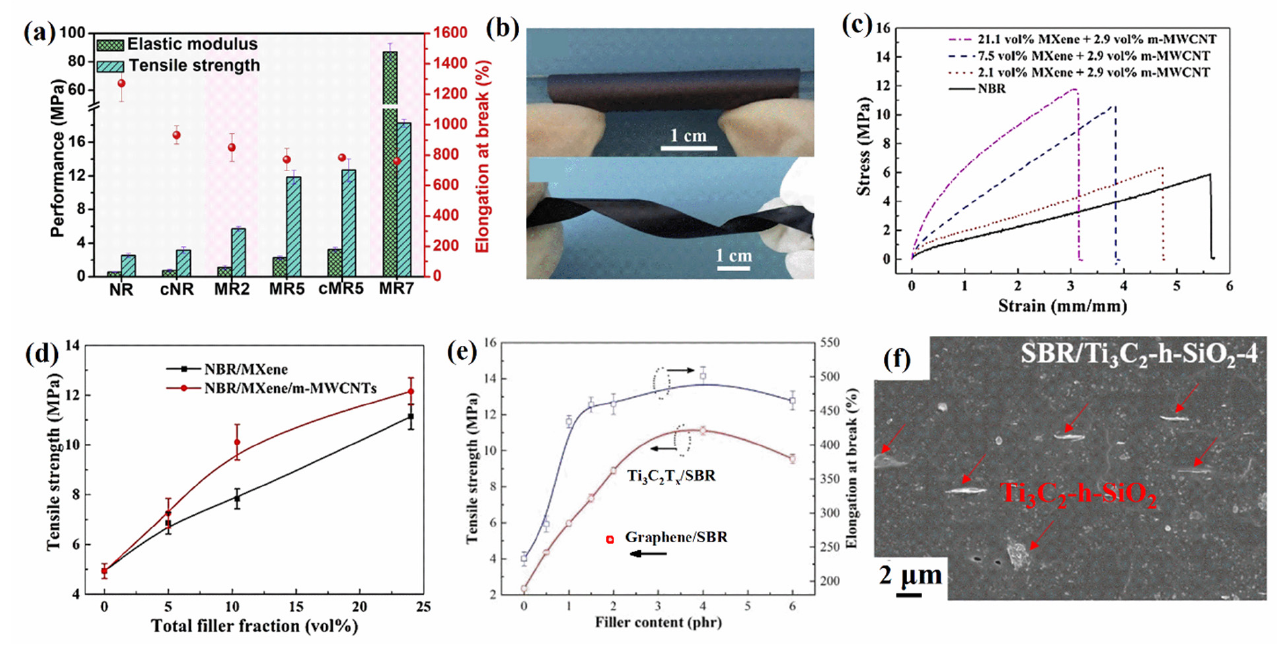
Figure 5. ( a ) Tensile strengths and elastic moduli of MXene/NR composite films (Reprinted with